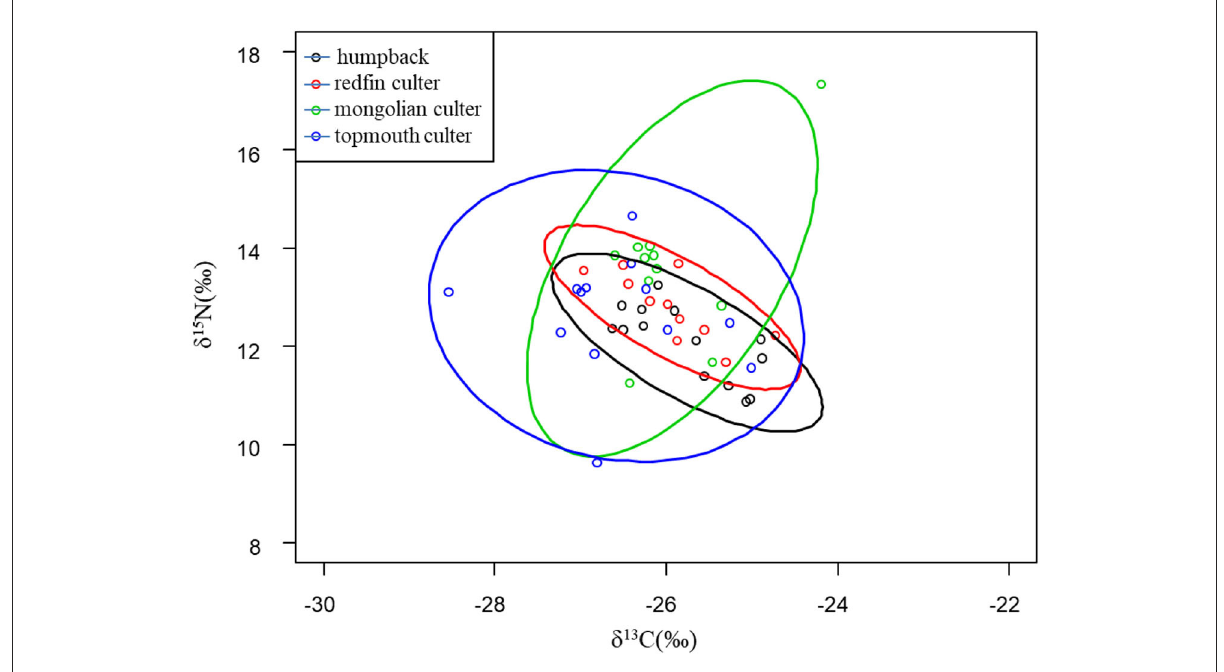
FIGURE3 Isotopic biplot of four fish species in Lihu